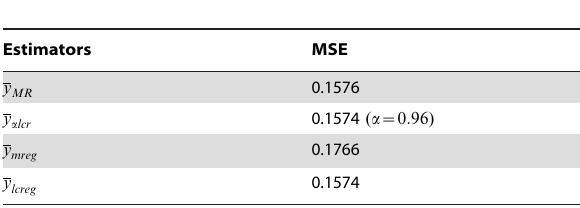
Table 2. MSE Values of